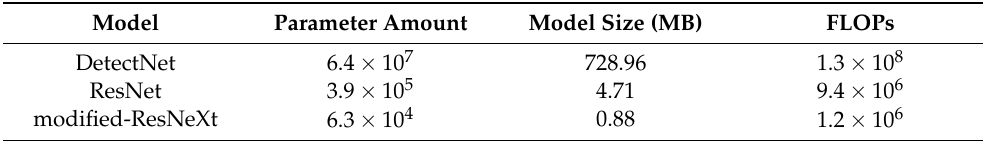
Table 2. Comparison of attributes different deep learning models. The attributes involved in the comparison are parameter amount, model size, and